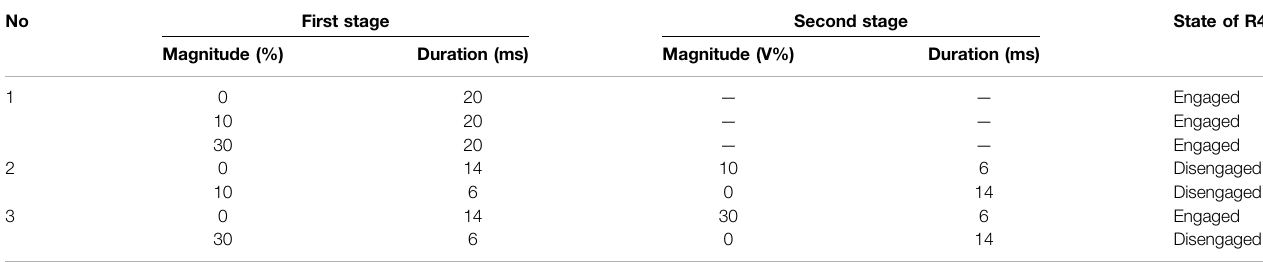
TABLE 3 | Test conditions and results to two-stage voltage sags for R4.